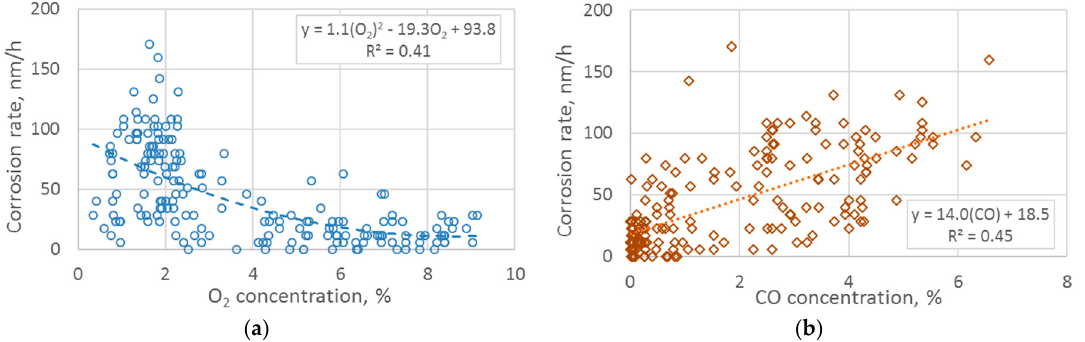
Figure 14. Dependence of corrosion rate (nm/h) on O 2 and CO concentration (( a ) and ( b ), respectively) in the boundary layer of the combustion chamber.